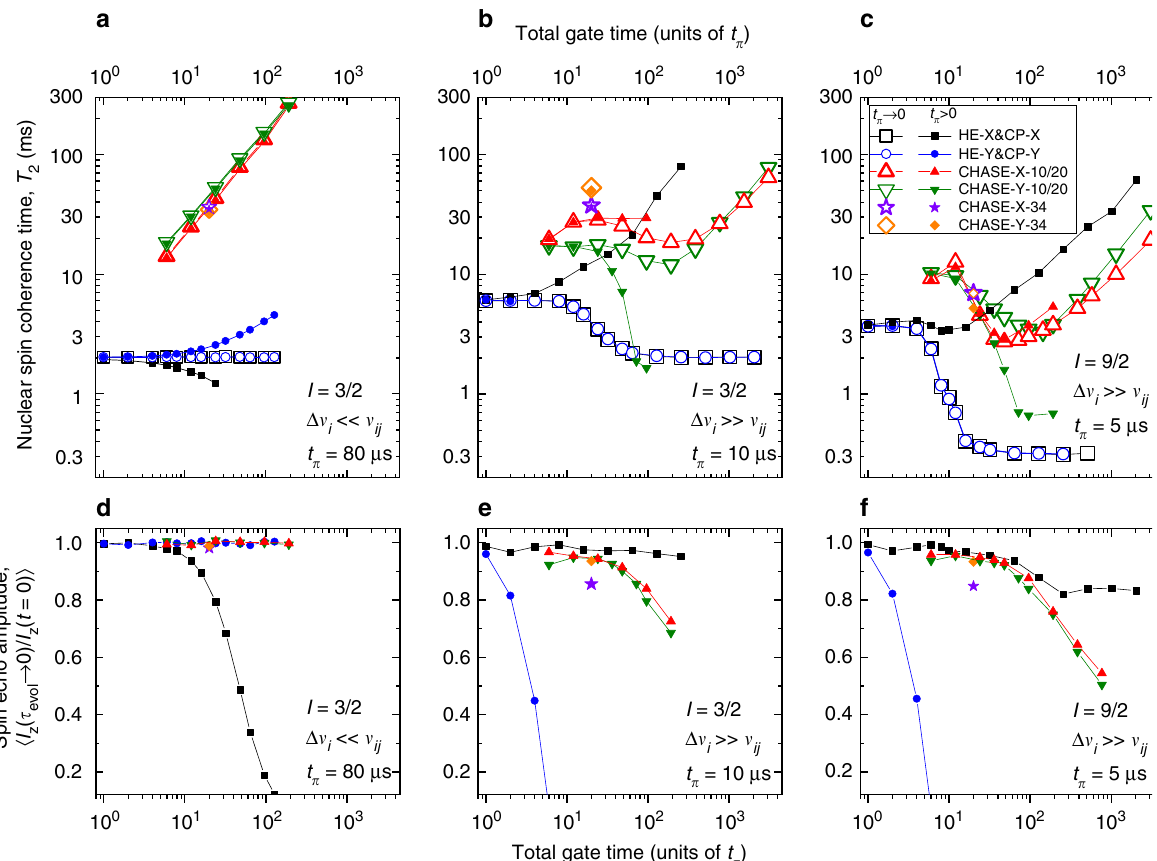
Fig. 4 Simulated decoherence of a dipolar-coupled nuclear spin ensemble. Numerically simulated spin echo decay under different pulse sequences (see Supplementary Note 4 for representative data and further details) is fi tted using Eq. (3) to derive nuclear spin coherence time T 2 and the normalised spin echo amplitude 〈 I z ( τ evol → 0)/ I z ( t = 0) 〉 for short free evolution. a – c Fitted T 2 as a function of the total gate time. d – f Corresponding gate time dependence of the spin echo amplitude. The results are presented for spin-3/2 75 As nuclei with small inhomogeneous (quadrupolar) broadening Δ ν i ( a , d ), 75 As with large Δ ν i ( b , e ) and spin-9/2 115 In nuclei with large Δ ν i ( c , f ). Simulations are done for both in fi nitely short ( t π → 0, open symbols) and fi nite pulses (solid symbols, t π = 5, 10 or 80 μ